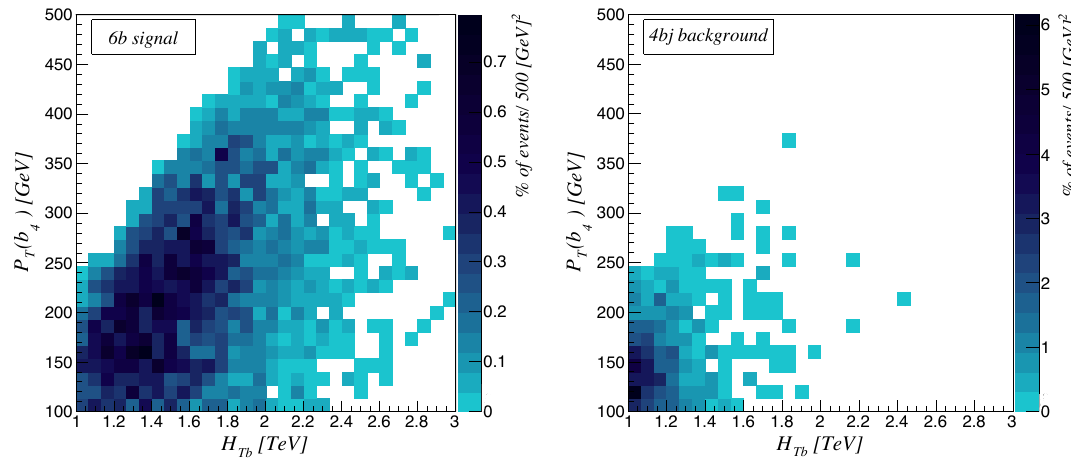
Figure 6 . Left: distribution of events for the 6 b signal in the [ H Tb ; P T ( b 4 )] plane for m b 4 = 1 : 5 TeV. Right: distribution of events for the 4 bj background in the [ H Tb ; P T ( b 4 )] plane. In both panels, P T ( b 4 ) is the transverse momentum of the fourth-highest p T identi(cid:12)ed b -jet.